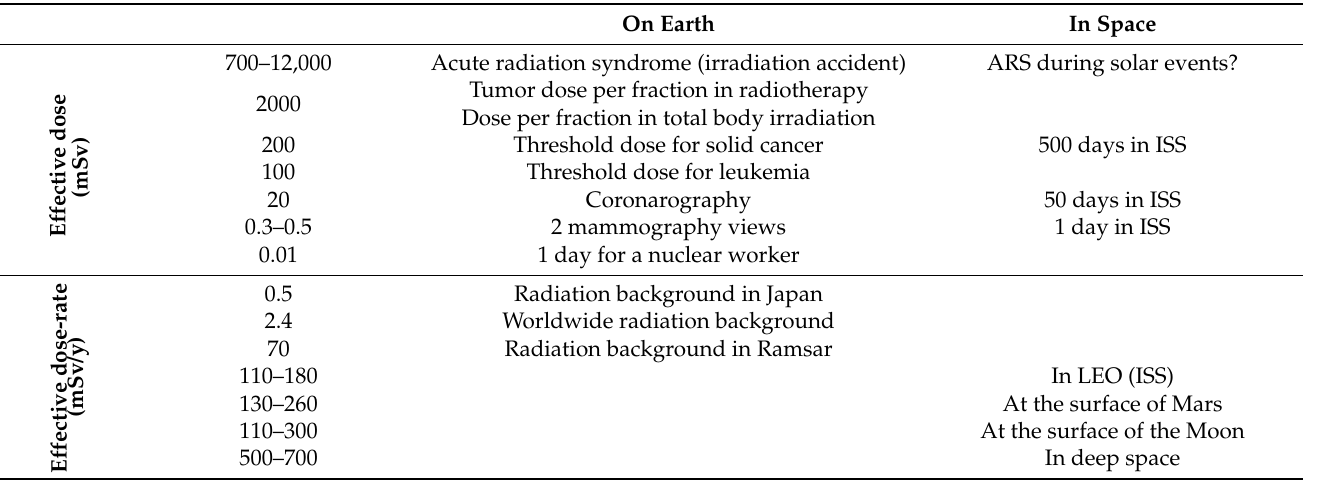
Table 2. Current average effective dose and dose-rates of interest for different exposures to IR. On